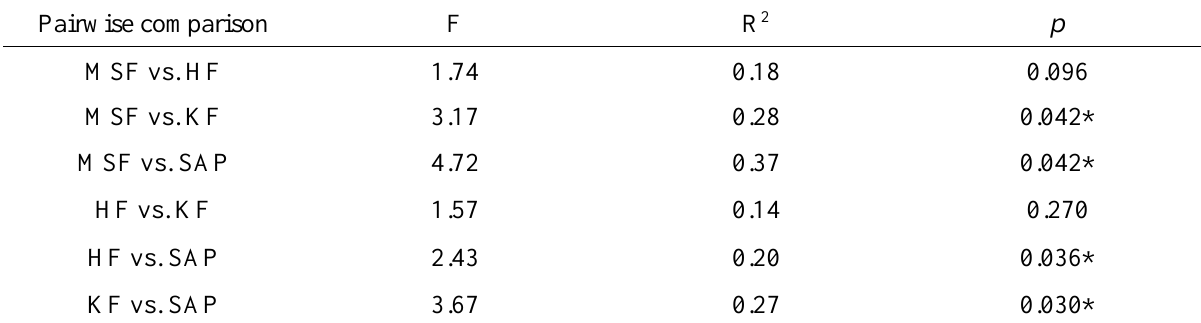
Table 4. Pairwise PERMANOVA test results, based on presence-absence data, to show pairwise differences in seedling community composition between forest types: mixed peat-swamp forest (MSF), heath forest (HF), kerapah (KF) and Shorea albida peat-swamp forest (SAP). The PERMANOVA for presence-absence data was highly significant at p < 0.001 with R 2 of 0.30. * indicates significant difference at p < 0.05. Pairwise